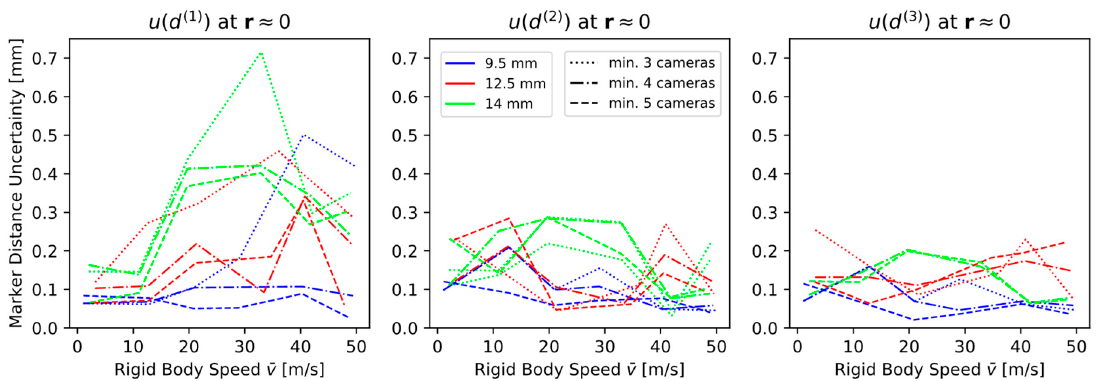
Figure 3. Uncertainties of marker distances plotted as function of mean rigid body speed for different marker sizes (colours) and numbers of cameras used for reconstruction